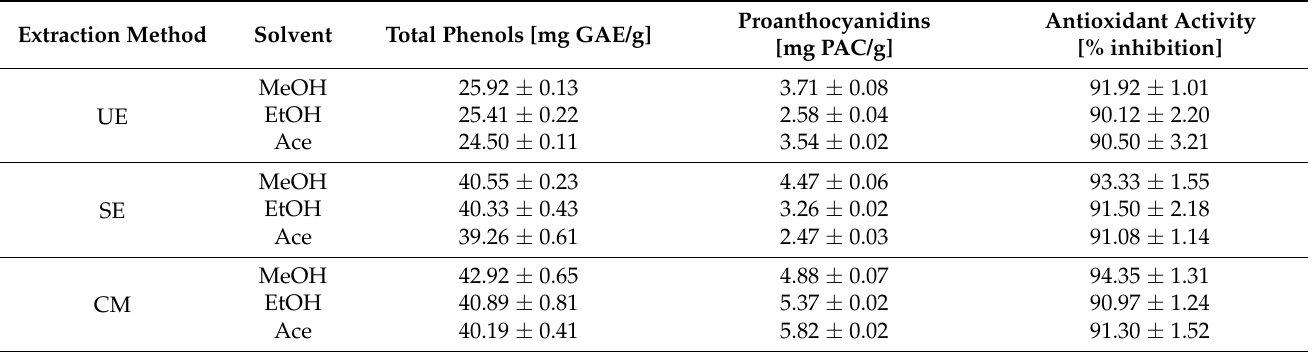
Table 1. Total phenols, proanthocyanidins and antioxidant activity of lyophilized PP extracts obtained by ultrasonic extraction (UE), Soxhlet extraction (SE), and cold maceration (CM).